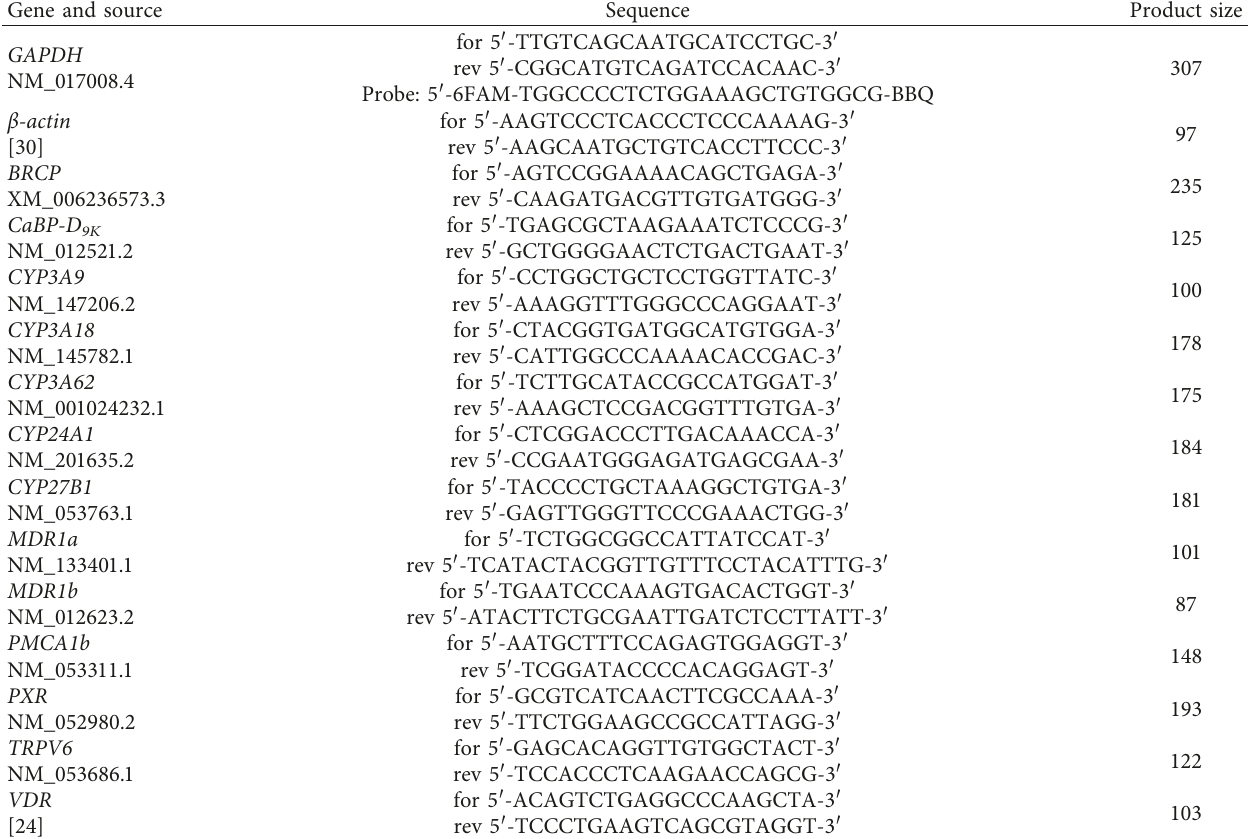
Table 1: Primers used for quantitative RT-PCR